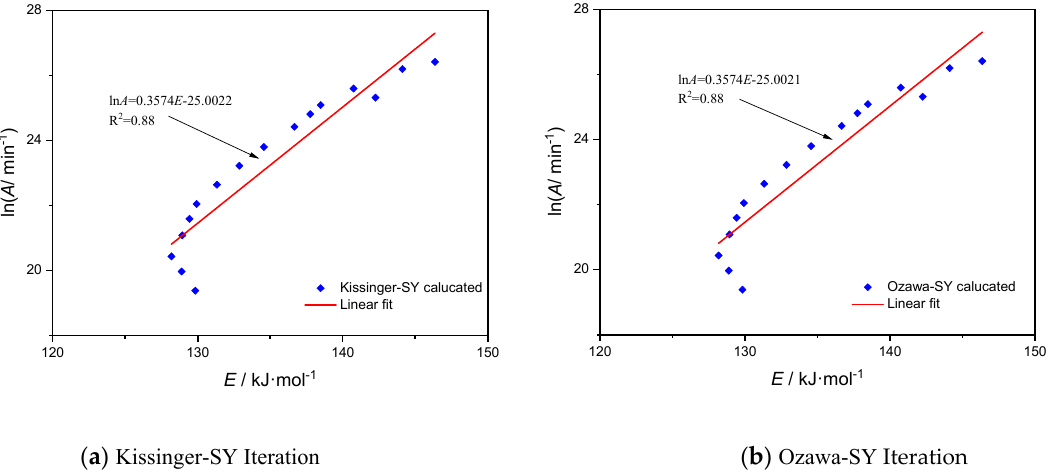
Figure 6. Linear correlation between the activation energy of EP/15% F-lignin@HKUST-1 and the preinhetial factor based on two iterative methods.